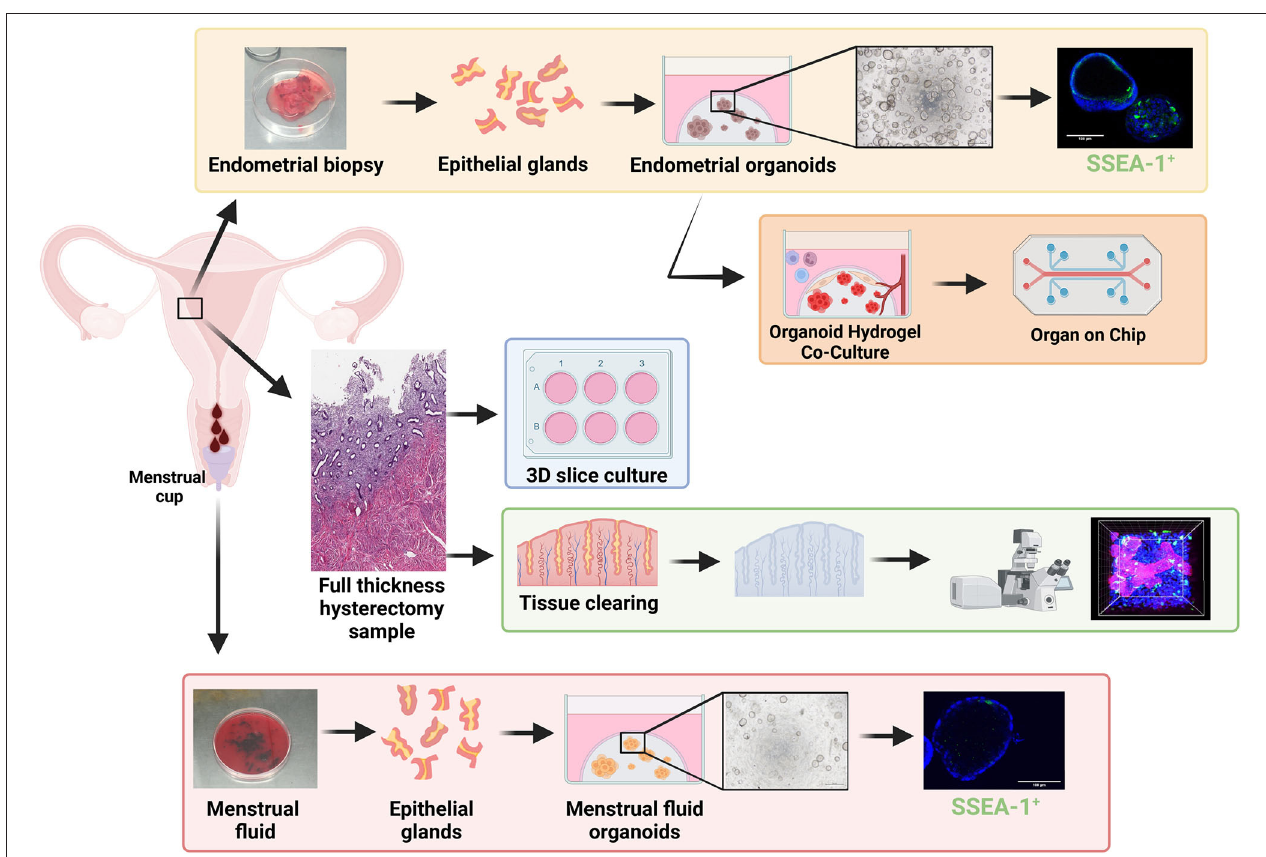
FIGURE 2 | Stem/progenitor cells in in vitro models of repair and regeneration. Endometrial biopsies can be used in 3D organoid experiments including single cell organoid culture (yellow box) and hydrogel-based co-culture and organ-on-chip systems (orange box) which show great promise for future endometrial research. Full thickness endometrium collected at hysterectomy has been used for; tissue clearing (green box) to visualize structures in 3D via high powered microscopy and used for 3D slice cultures (blue box). Menstrual fluid can be easily collected in a menstrual cup, from which menstrual fluid organoids (red box) can be generated. Created with